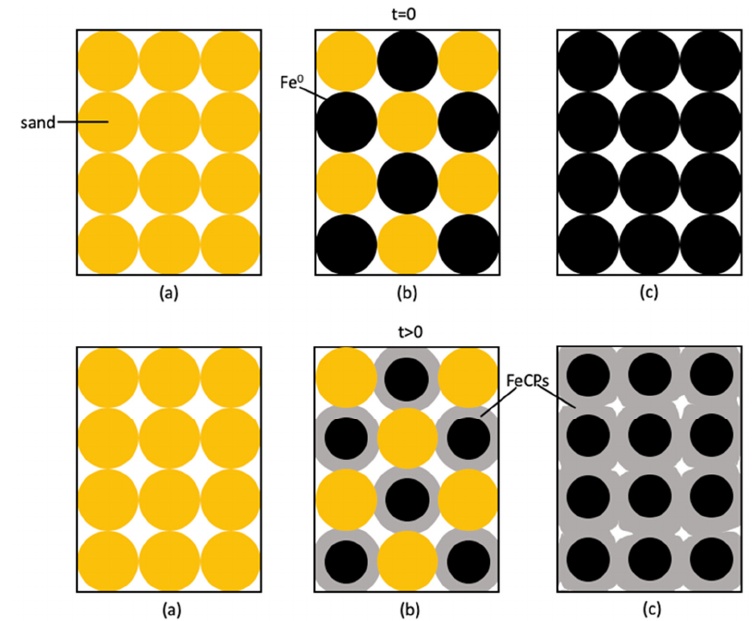
Figure 1. Schematic representation of the cross-section of three different filters containing ( a ) sand alone, ( b ) Fe 0 /sand (1:1), and ( c ) Fe 0 alone. The pure Fe 0 systems completely clog when the Fe 0 /sand system has just experienced 50% porosity loss. In all three systems, permeability loss due to inflow- ing colloids and suspended particles is also possible.